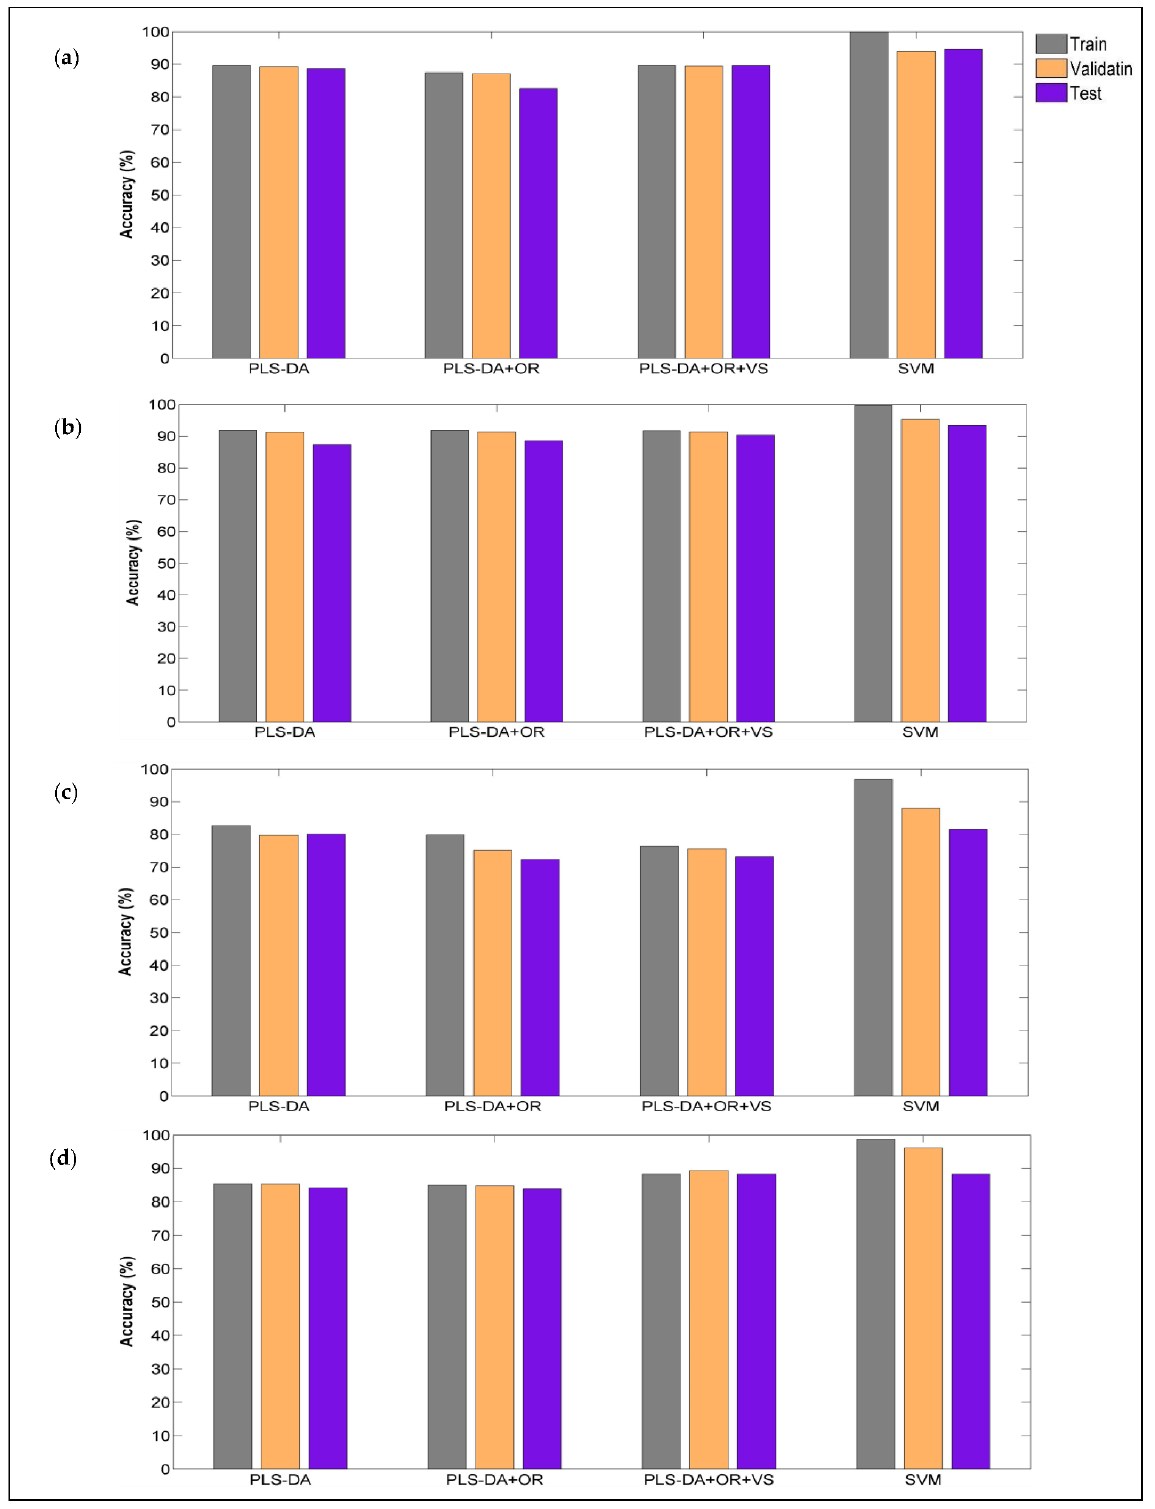
Figure 4. Classification accuracy of SVM and PLS-DA models in Vis-NIR and NIR sensors. Vis-NIR sensor: ( a ) intact meat samples; ( b ) ground meat samples. NIR sensor: ( c ) intact meat samples; ( d ) ground meat samples. Partial Least Squares Discriminant Analysis (PLS-DA); Outlier Removal (OR); Variable Selection (VS) and Support Vector Machine